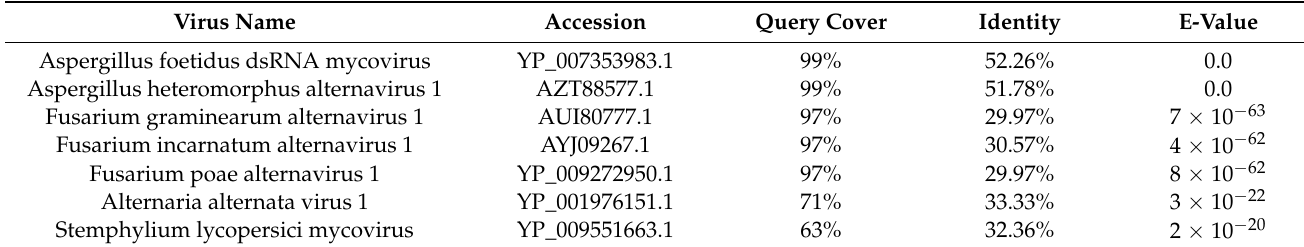
Table 3. Identity between FoAV1 ORF3-encoded protein and equivalent proteins of other proposed alternaviruses. Virus